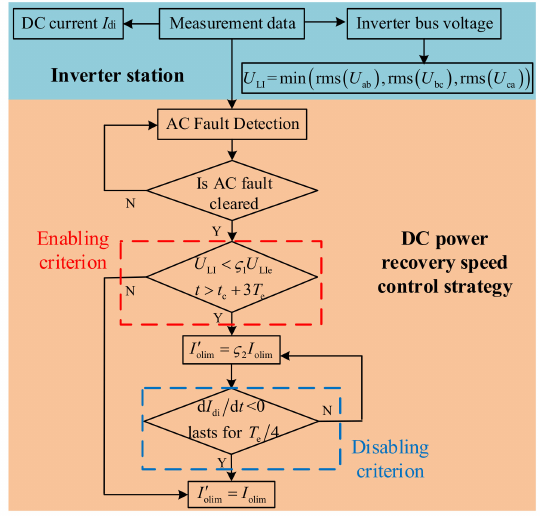
Figure 11. Procedure flowchart for the DC power recovery speed control.